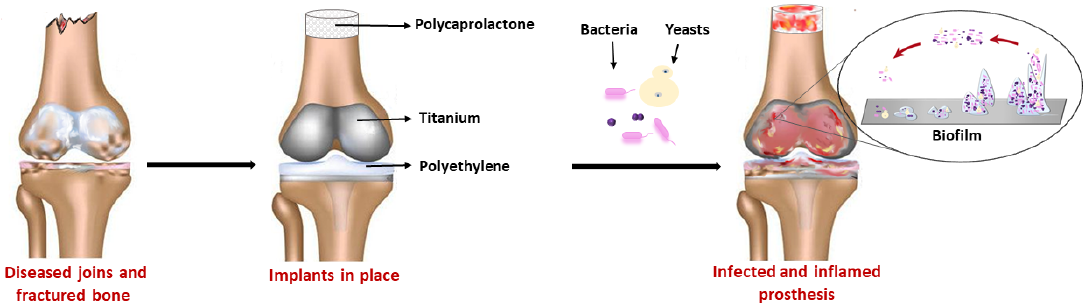
Figure 1. Orthopedic prosthetic surgery for the functional restoration of bone and joints is achieved surgically in total joint arthroplasties by using permanently implanted biomaterials such as titanium and polyethylene. Additionally, numerous bone fractures and other musculoskeletal problems need to be addressed using biodegradable biomaterials, such as poly(ε-caprolactone). The presence of a foreign body is a triggering event for prosthetic joint infection because the implant surface attracts free-floating bacteria, and this bacterium–surface interaction becomes irreversible thanks to biofilm formation.